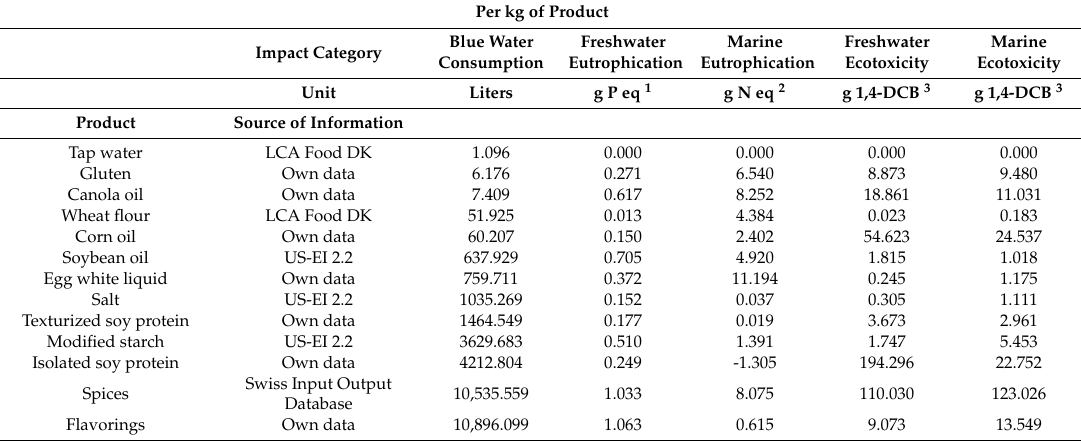
Table 2. Water-related impacts attributable to 1kg of the di ff erent ingredients included in the meat analogs, ranked by blue water